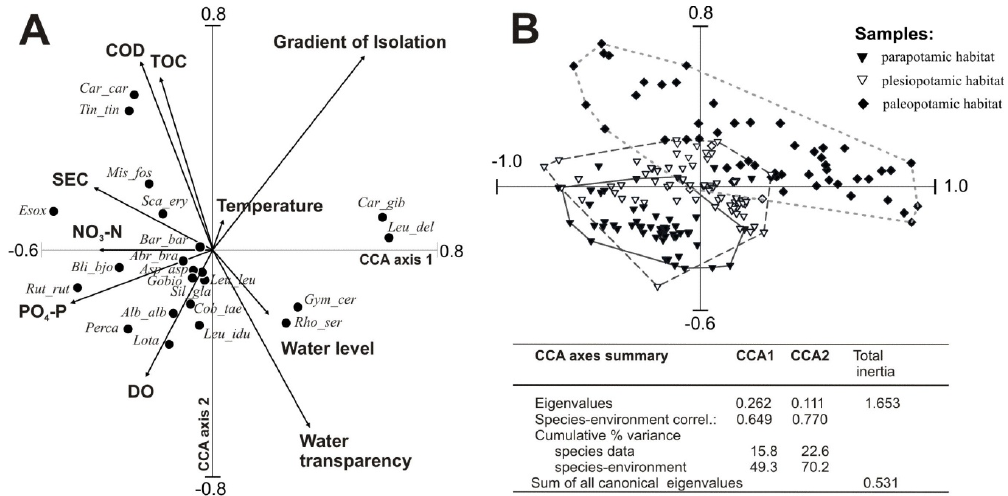
Figure 2. ( A ) Biplot of CCA relating score, fish, taxa abundance and environmental variables correlated with axes. Environmental variables are represented by arrows that approximately point towards the factor direction of maximum variation. The length of an arrow is proportional to the importance of that variable in assemblage ordination; ( B ) CCA ordination plot of samples grouped according to hydrological connectivity. Inserted table shows summary of the results of the CCA including eigenvalues, correlations and percentage of variation explained by the two canonical axes (CCA1 and CCA2). For fish species abbreviations, see Table 2.